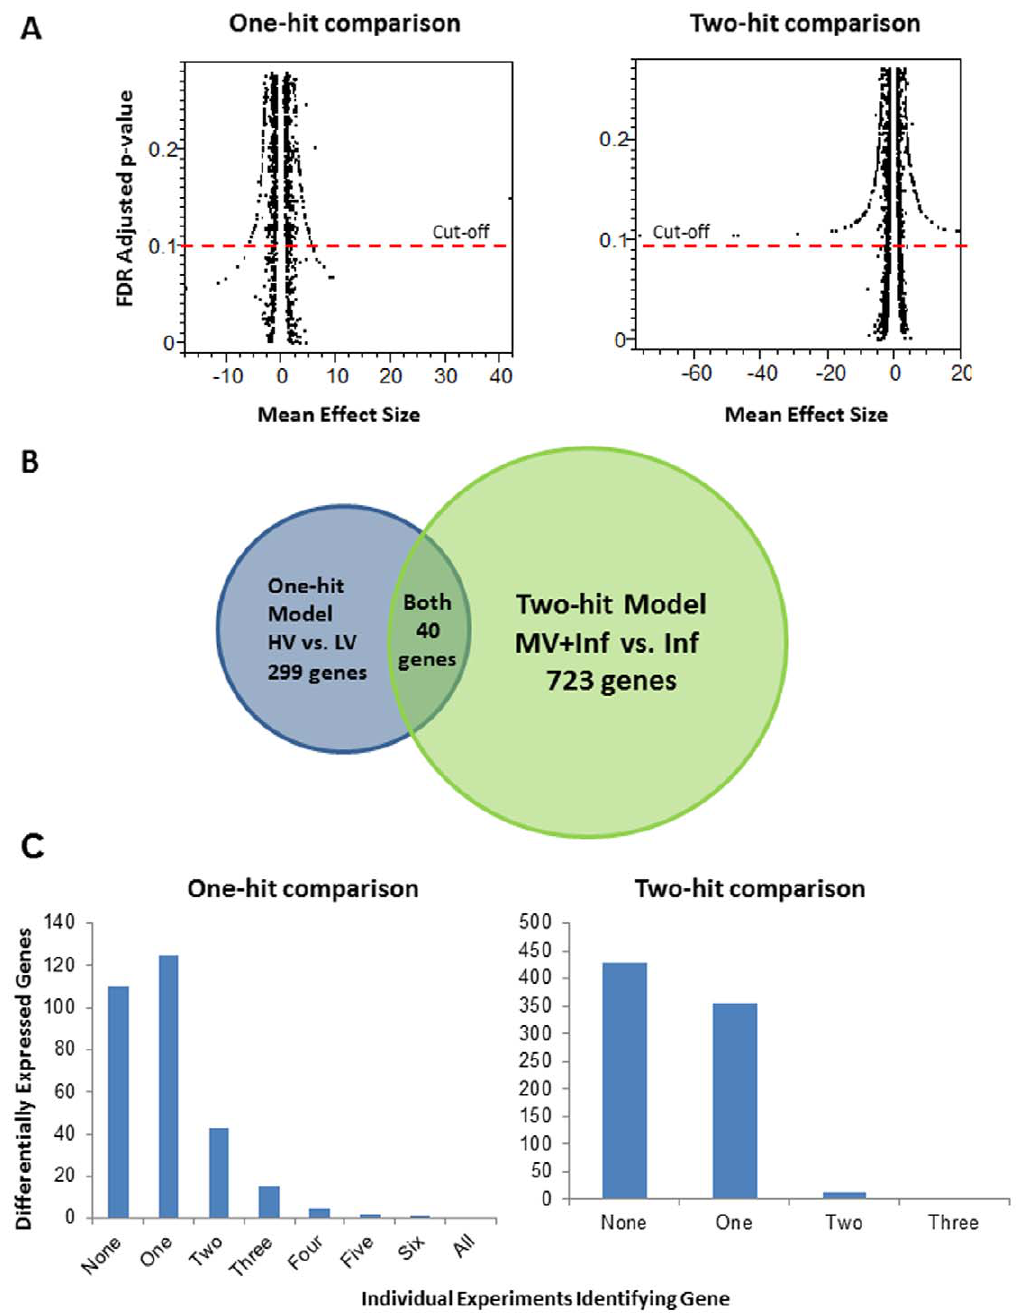
Figure 2. Identification of Acute Lung Injury Profiles. ( a ) Relationship between adjusted pvalue and mean effect size (MSE). ( b ) Overlap of significantly expressed genes (FDR # 0.1) between one-hit and two-hit models of VILI . Significantly altered probesets were matched between one-hit and two-hit models of VILI and collapsed to their corresponding genes using the annotation file for the Affymetrix U133 Plus 2.0 chip. ( c ) Identification frequency of significantly expressed genes from one-hit and two-hit models of VILI . Significantly expressed genes (FDR # 0.1) in the individual experiments were chosen using two-class unpaired SAM. Rat and mouse datasets from GSE2368 were considered one experiment, and normalized data provided in supplementary data was used for analysis. The frequency of the significantly expressed genes from meta-analysis of one-hit and two-hit models of VILI were evaluated by counting the times these genes were also found significantly expressed in individual experiment. Note: ‘‘All’’ means all the experiments used in meta-analysis; ‘‘None’’ means genes only found in meta-analysis but not in individual experiments. doi:10.1371/journal.pone.0045506.g002 including ‘NF- k B signalling’, ‘IL-10 signalling’, ‘IL-6 signalling’ and ‘NRF-2 mediated oxidative stress response’ ( Table 6 ). (Animal Models of ALI and VILI). We validated our gene